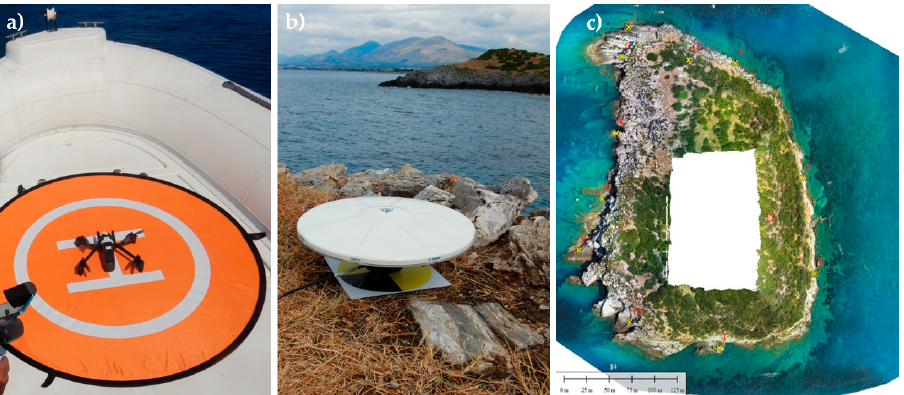
Figure 5. ( a ) Unmanned Aerial Vehicle (Anafi Parrot Work UAV) survey performed from a small boat; ( b ) GNSS surveys carried out along the coast of Cirella Island to identify the 11 ground control points; ( c ) UAV Mosaic image of Cirella Island.